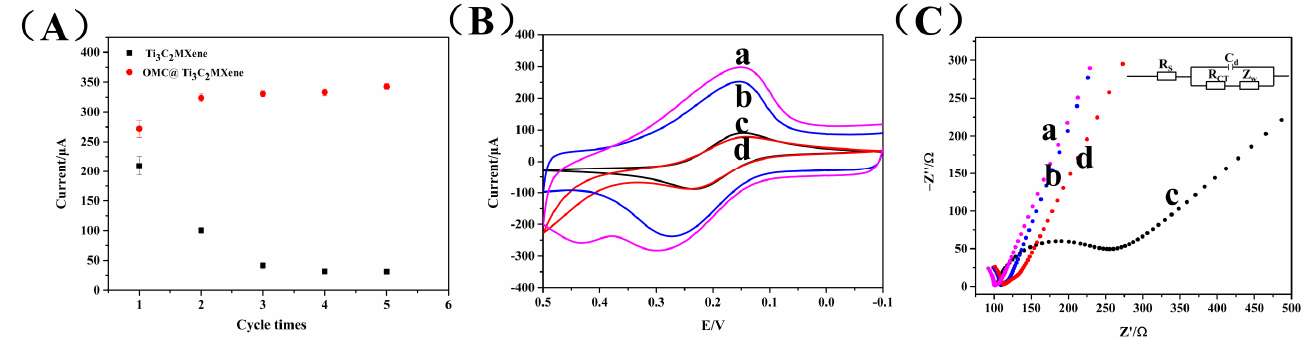
Figure 2. ( A ) The stability of electrode with treatment of Ti 3 C 2 MXene and OMC@ Ti 3 C 2 MXene; CV ( B ) and EIS ( C ) curves, a: Ti 3 C 2 MXene/OMC-CS/SPCE; b: OMC-CS/SPCE; c: Bare/SPCE; d: Ti 3 C 2 MXene/SPCE.